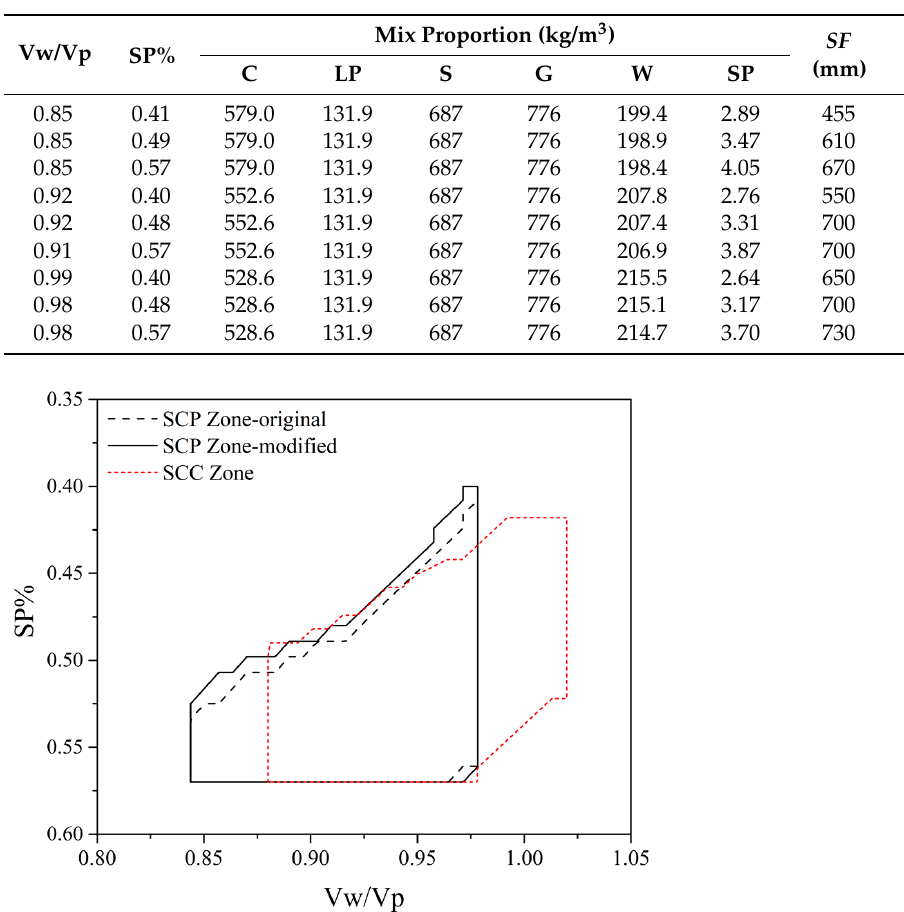
Table 11. Mix proportions and test results of SCC in series 4.